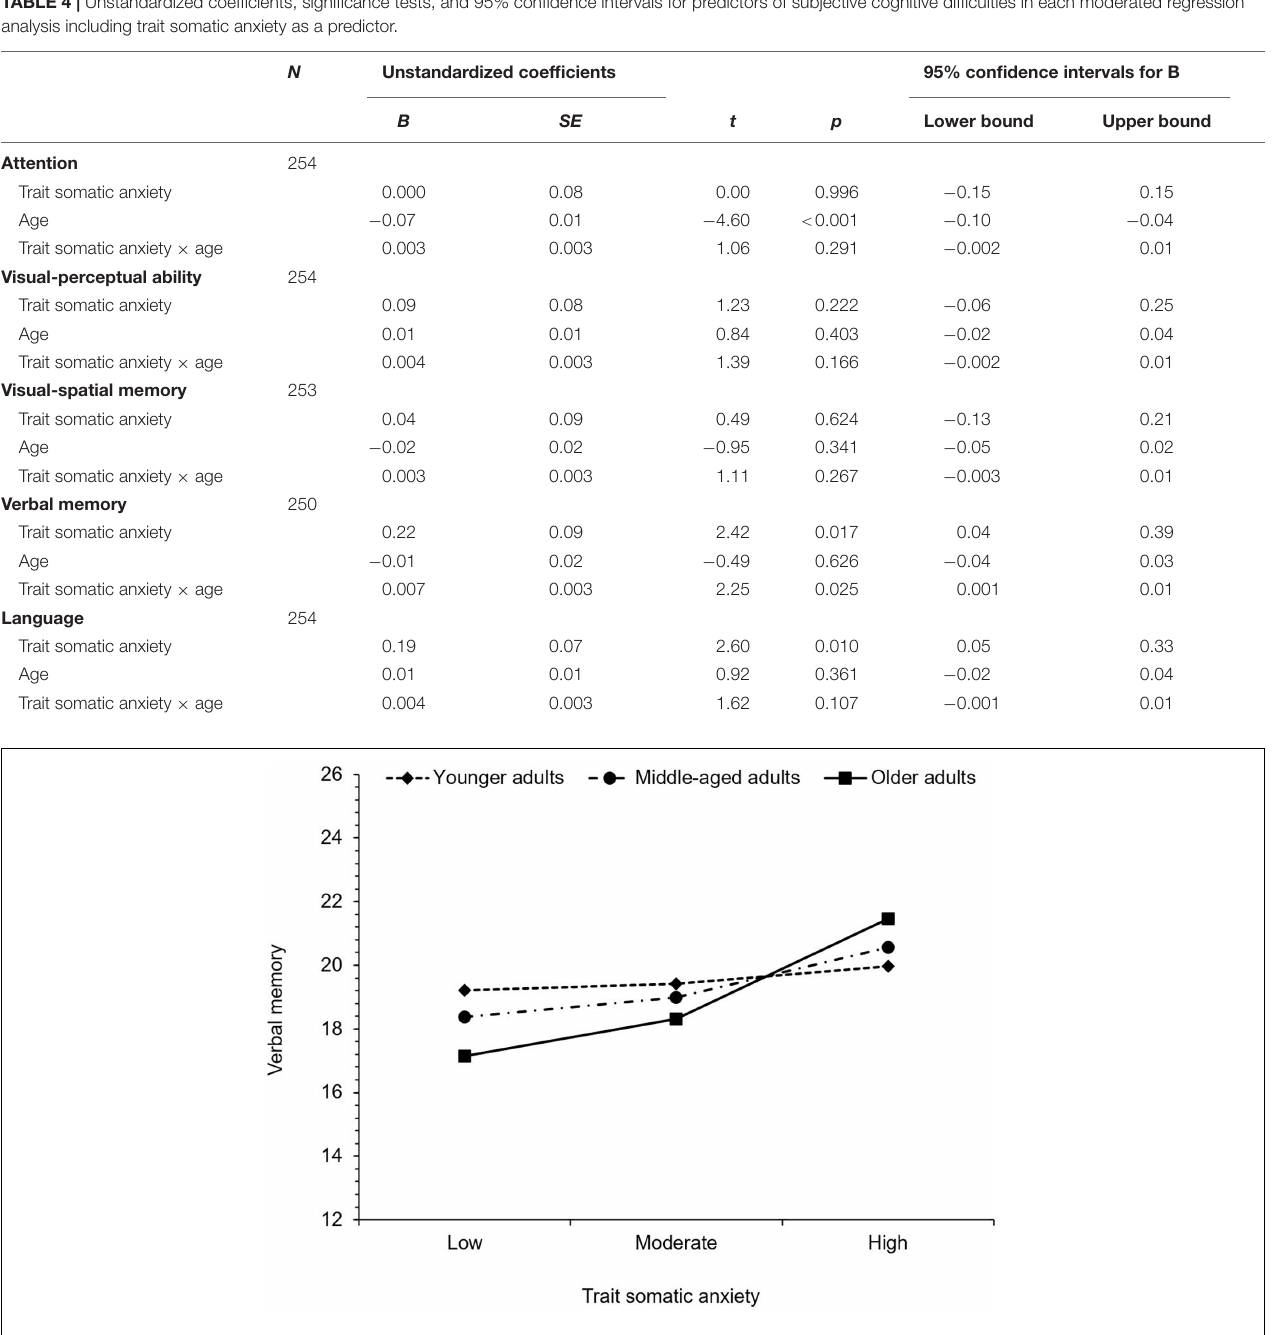
FIGURE 5 | Simple slopes illustrating the significant interaction between trait somatic anxiety and age on verbal memory. Higher values indicate greater levels of subjective cognitive